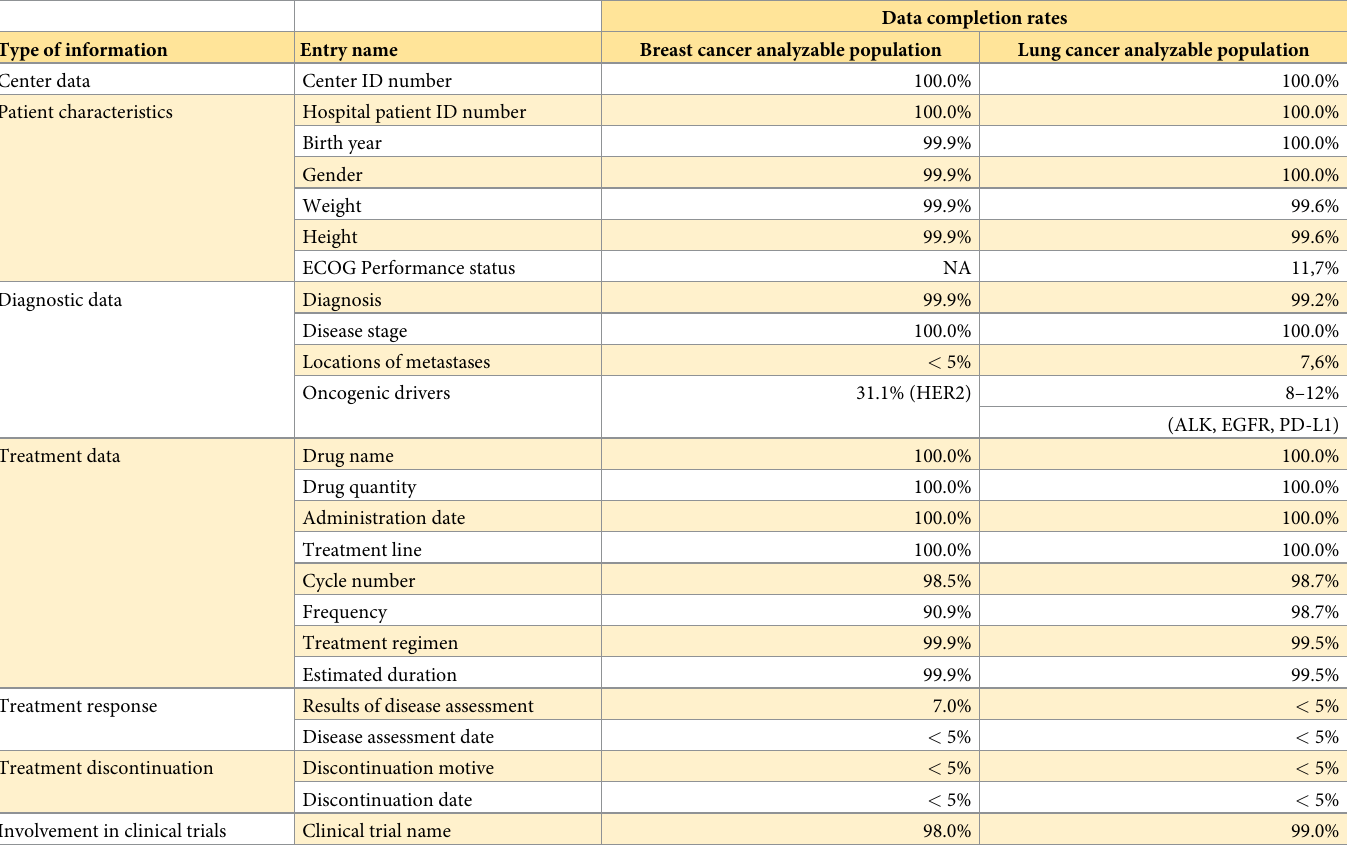
Table 1. List of data extracted from electronic pharmacy record systems and data completion rates in the breast cancer and lung cancer analyzable